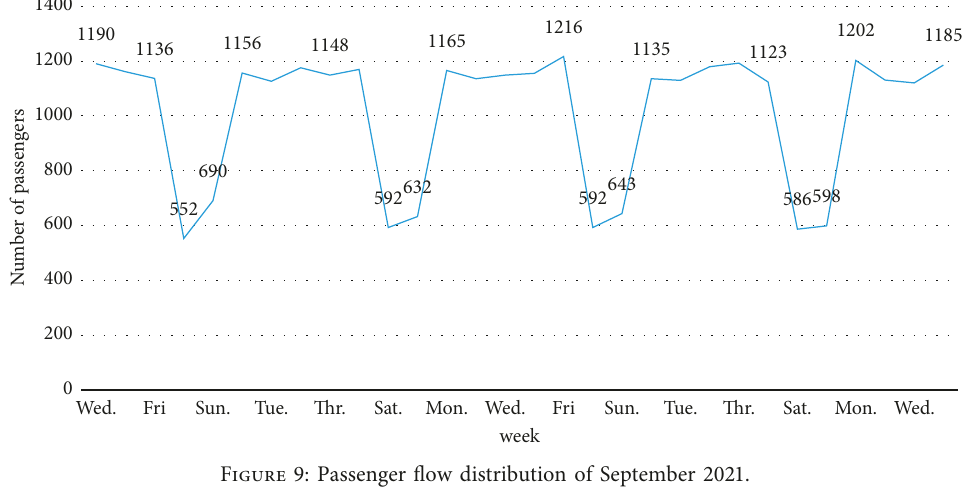
Figure 9: Passenger flow distribution of September 2021.